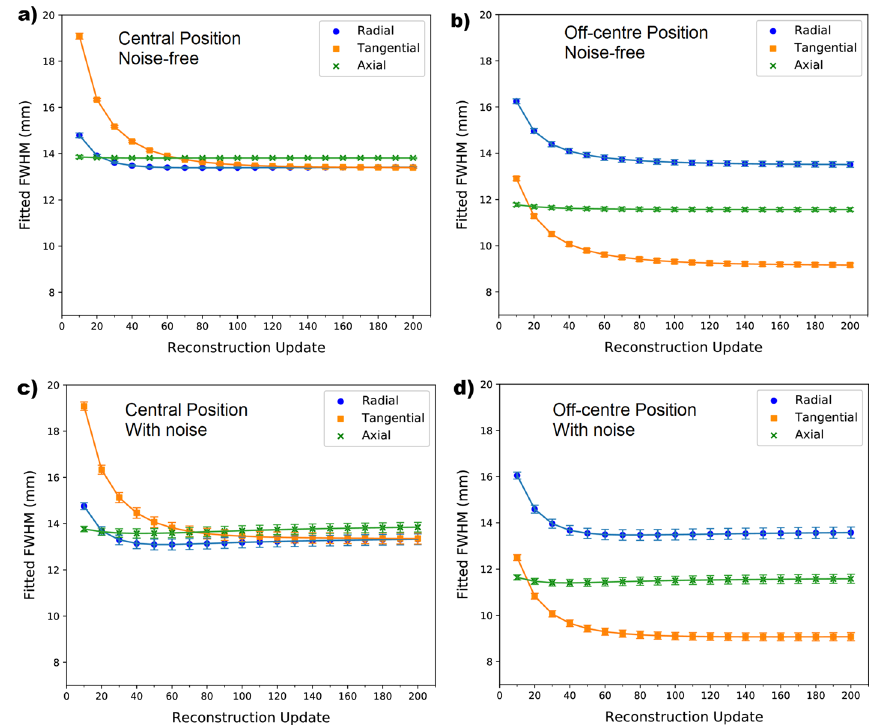
Fig. 3 FWHM measurements in each direction vs reconstruction update number (10 updates iteration) measured in a central lesion without noise, b off‑centre lesion without noise, c central lesion with noise and d off‑centre lesion with noise. The perturbation point was positioned in the centre of a 36 mm radius lesion and the lesion TBR was 10 in all cases shown. Error bars relate to the standard deviation in the fitted FWHM parameters but are too small to be seen clearly on noise‑free data